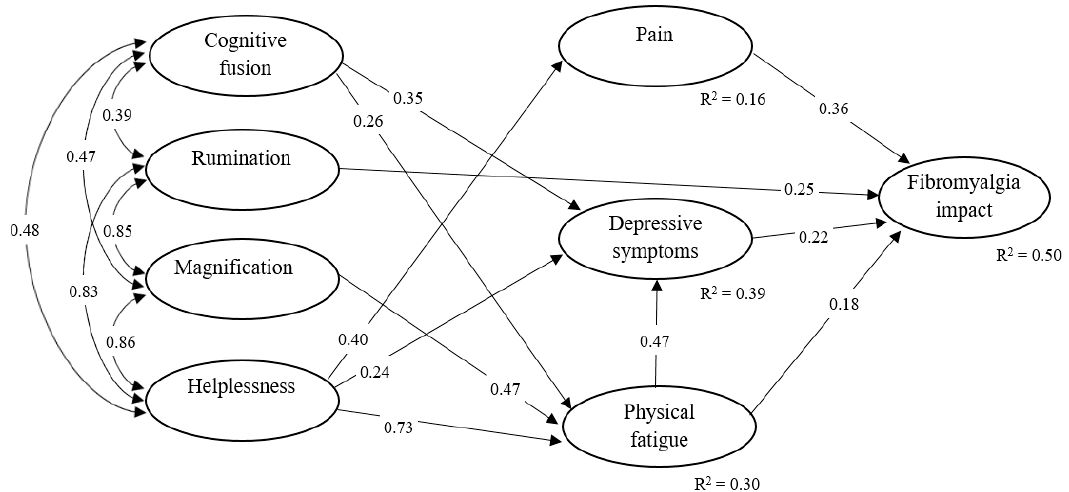
Figure 3. Standardized coefficients of the re-specified model (M2). Only significant paths and the latent factors of the model are shown; the observed indicators and measurement errors have been omitted for space and clarity reasons. The squared multiple regression coefficients (R 2 ) reflect the amount of factor variance associated with variance of its independent variables.